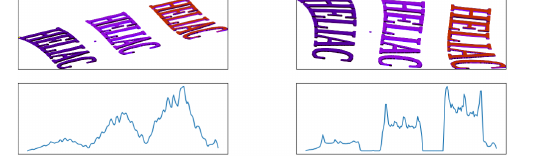
FIG. 2. Example of reconstruction setup for a transformation between image and trace. The observed traces constrain the shape of the reconstructed object [51].